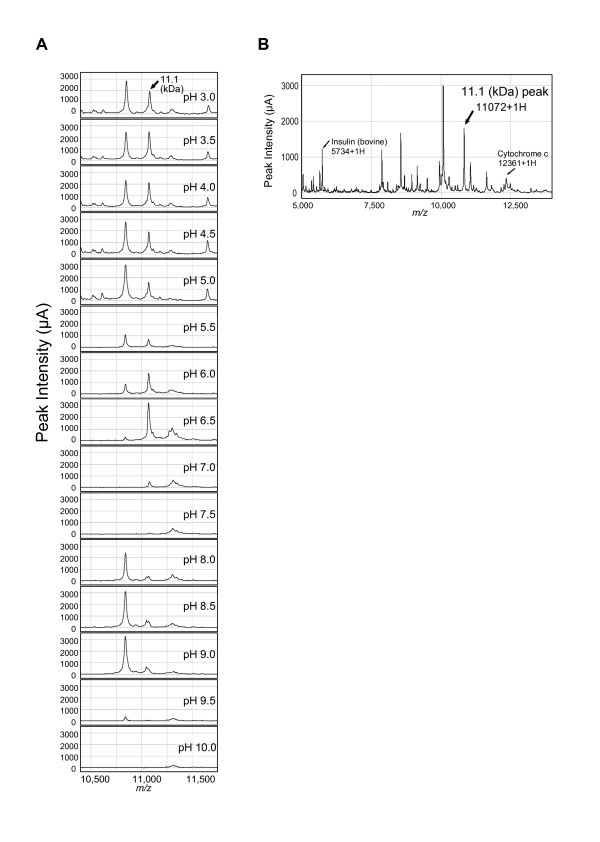
Characterization of the 11.1 kDa protein. (A) Estimation of pI of the 11.1 kDa protein. The affinity of the 11.1 kDa protein (indicated by the arrow) to a CM10 array changed with a pH range of 3.0-10.0. (B) Estimation of experimental molecular mass of the 11.1 kDa protein (indicated by the arrow). Bovine insulin (5733.5 Da) and equine cytochrome C (12361.0 Da) were calibrants for internal calibration.